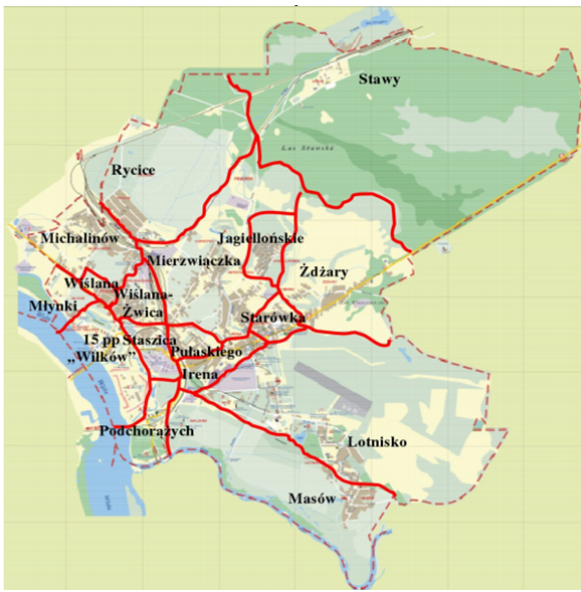
Figure 8: Administrative division of Dęblin [33]